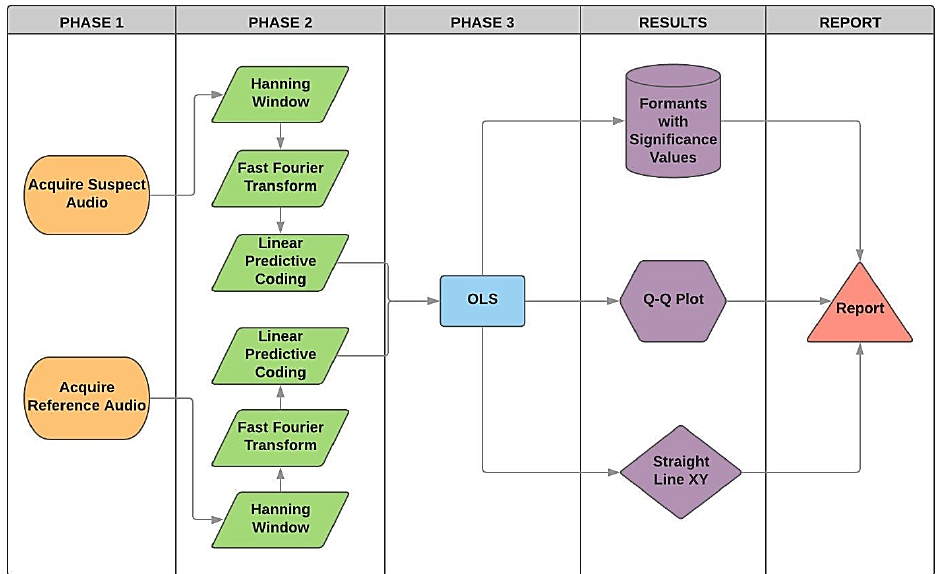
Figure 3. Structure developed for forensic speaker comparison, based on ordinary least squares (OLS), including all three phases.